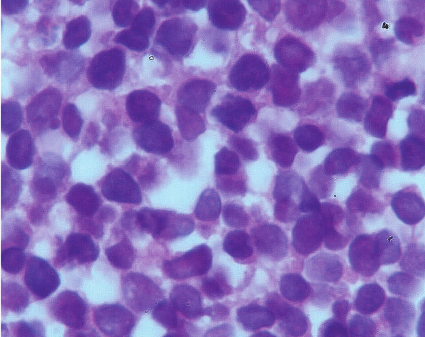
Figure 1: Plaques of confluent papules, reddish brown on the groins, pubis, and gluteal fold, firm, and well demarcated.